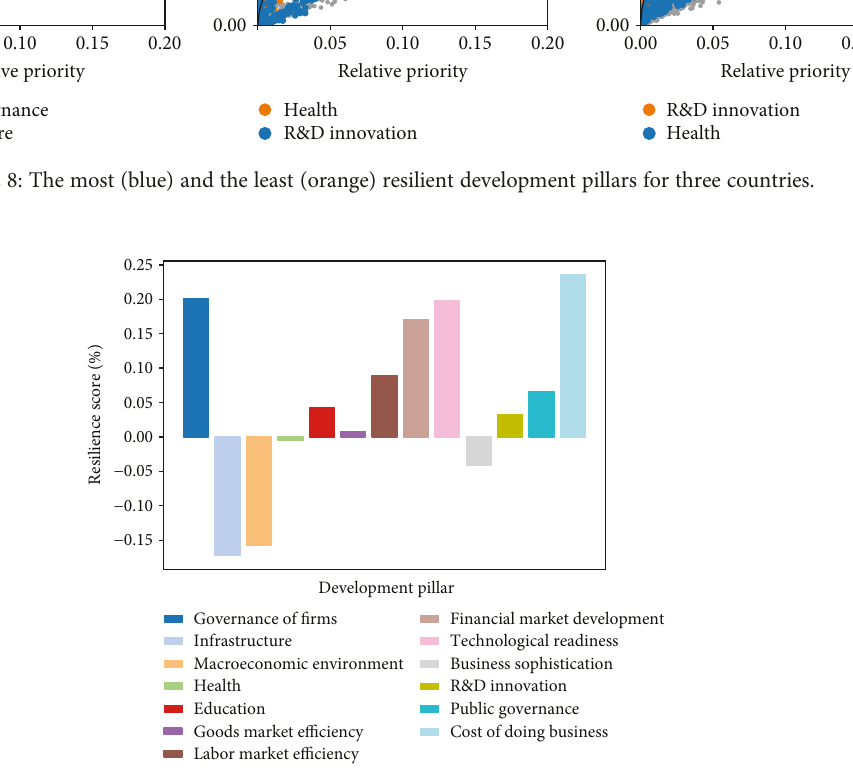
Figure 9: Average resilience by development